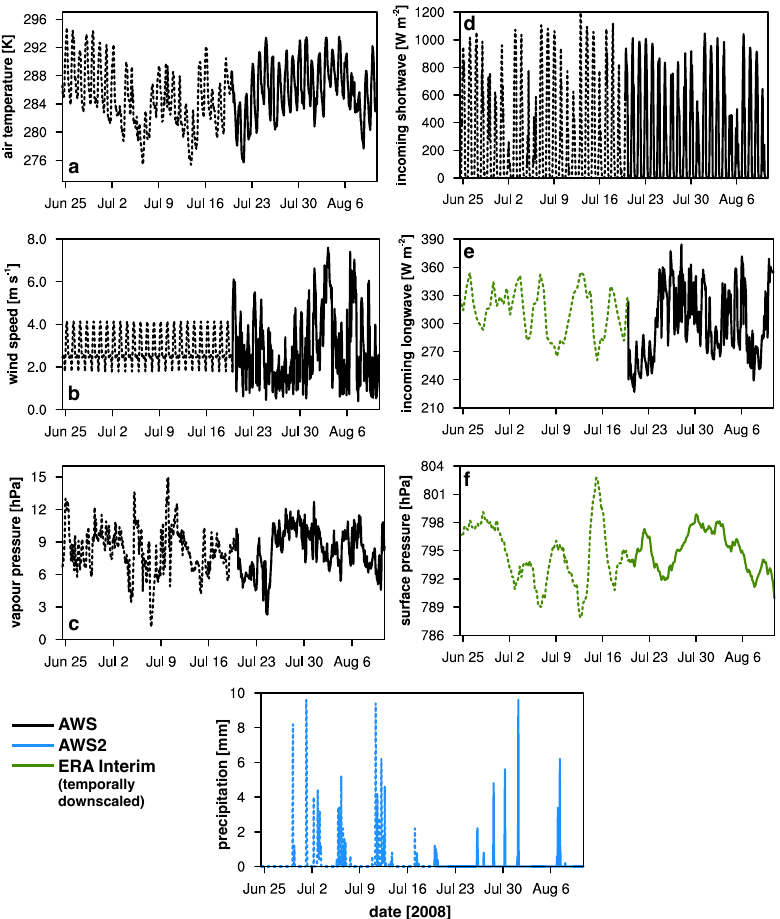
Figure 3. Times series from the 2008 simulation of the forcing variables of (a) 2m air temperature (K), (b) wind speed (ms − 1 ), (c) 2m vapour pressure (hPa), (d) incoming shortwave radiation (Wm − 2 ), (e) incoming longwave radiation (Wm − 2 ), (f) surface pressure (hPa), and (g) precipitation (mm). Data from the AWS on the Miage Glacier are shown in black, from the second AWS (4km away) in blue, and temporally downscaled from the ERA-Interim reanalysis in green. Dashed curves indicate the discarded spin-up period, while solid curves indicate the simulation time.